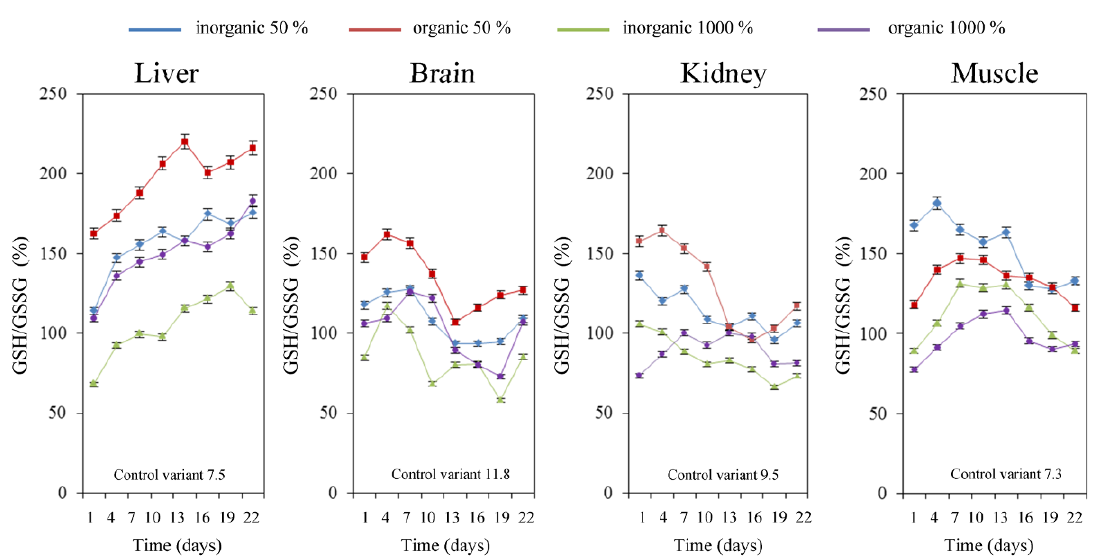
Figure 2. GSH/GSSG levels in the examined organs. The level was related to the controls. Error bars indicate standard error of mean for three specimens. Both reduced and oxidized glutathione were quantified using high performance liquid chromatography with electrochemical detection. The GSH/GSSG results were related to a control group and recalculated as a percentage of control. Control group was determined as a one hundred percent from individual values as follows: liver 7.5, brain 11.8, kidney 9.5 and muscle